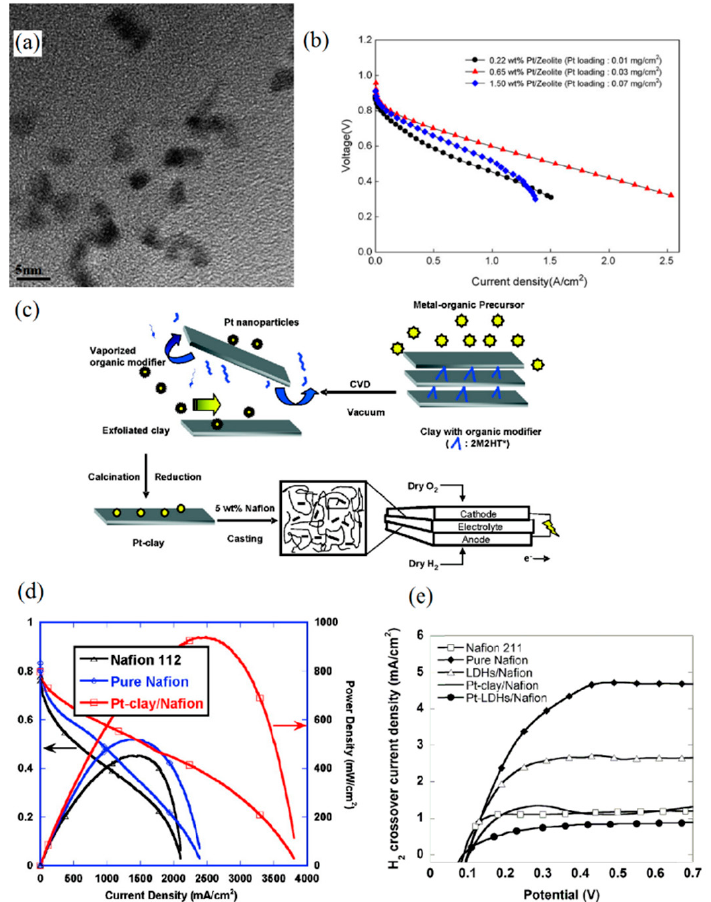
Figure 3. ( a ) TEM image of Pt/zeolite powder for self-humidification purpose and ( b ) I-V (polarization) curves of Pt–zeolite PEMs with different catalyst loadings at 50 °C in dry conditions (reprinted with permission from [58]); ( c ) process of exfoliated Pt–clay/Nafion membrane preparation and ( d ) polarization curves for plain Nafion and Pt–clay Nafion membrane under dry conditions at 60 °C (reprinted with permission from [59]); ( e ) hydrogen cross-over of plain Nafion, Pt–clay/Nafion, and Pt–LDHs/Nafion membrane (reprinted with permission from [61]). LDH: layered double hydroxides.